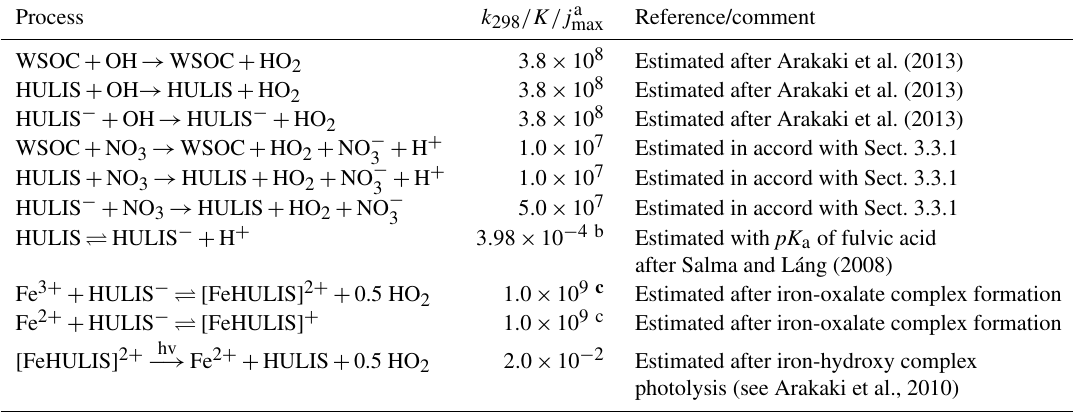
Table 1. Parameterizations for the aqueous-phase chemistry of WSOC and HULIS compounds.